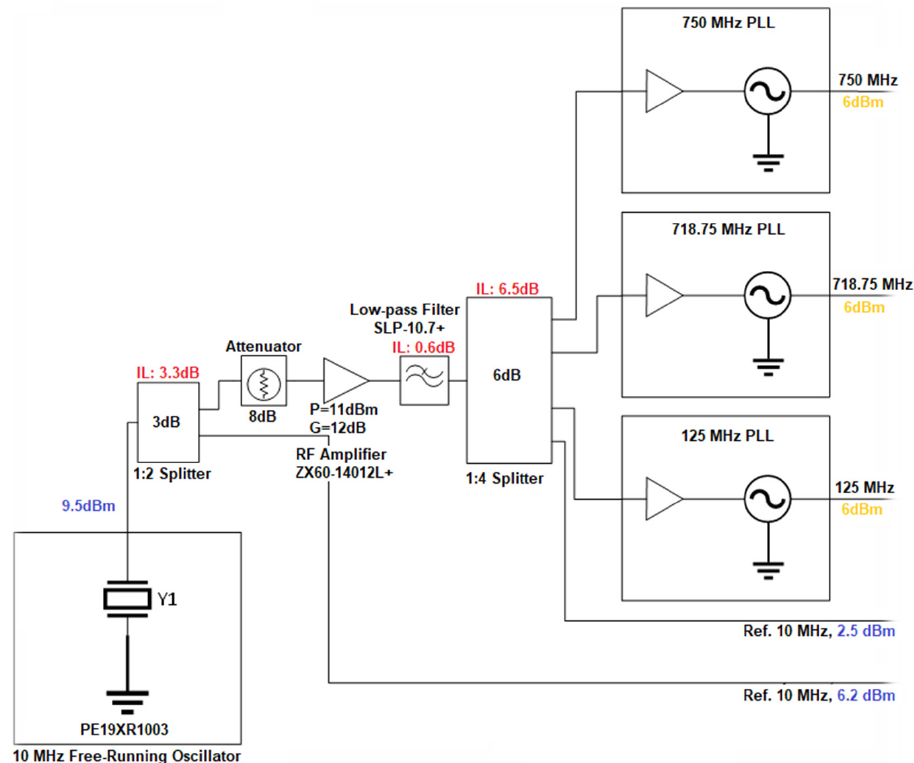
Figure 9. Internal structure of the synthesizer block. The different components used are shown with their insertion losses (in red), gains and compression point at 1 dB in the case of the amplifier, as well as the nominal output powers (synchronization signals in blue and RF outputs in yellow).